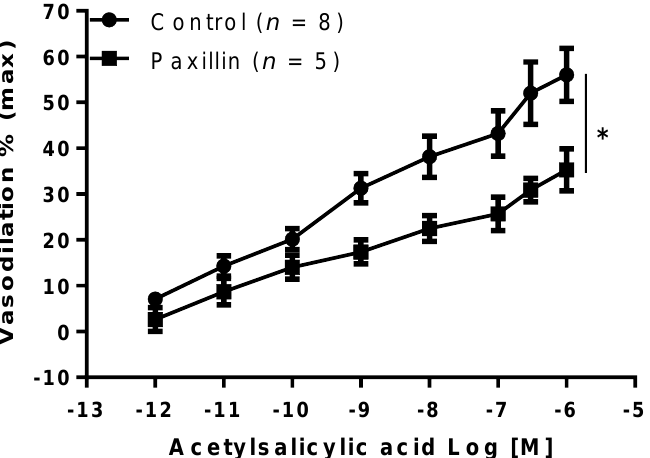
Figure 6. Effect of acetylsalicylic acid in the presence of BKca channel inhibitor. Acetylsalicylic acid was tested on mesenteric arteries isolated from gravid rats in the absence (Control) or in the presence of big potassium channel (BKca) inhibitor (paxillin, 10 −5 M). Data are reported as mean ± SEM, n = number of experiments, * p < 0.05 (two-way ANOVA).